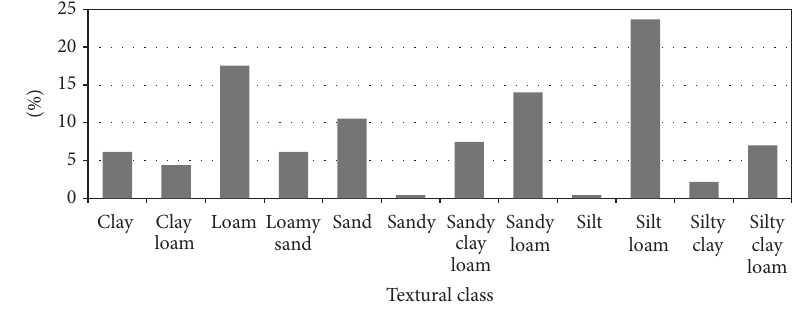
Figure 2: Textural composition of the